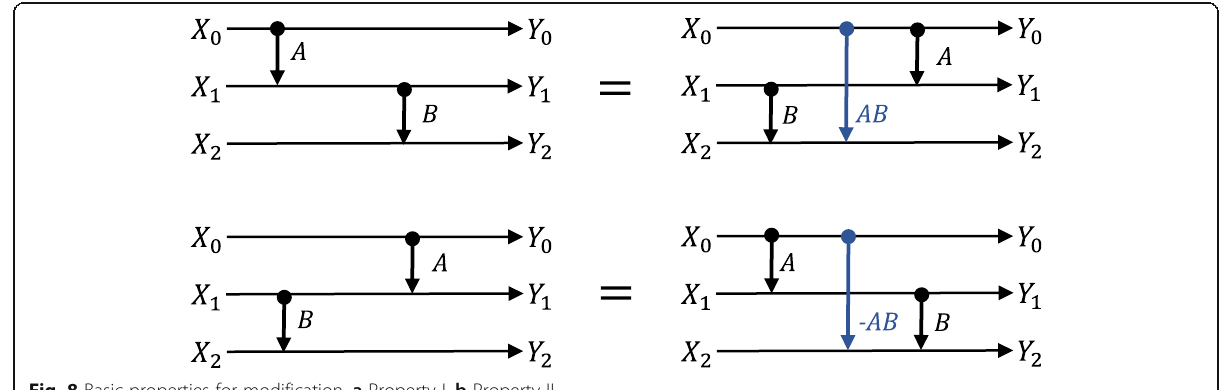
Fig. 8 Basic properties for modification. a Property I. b Property II